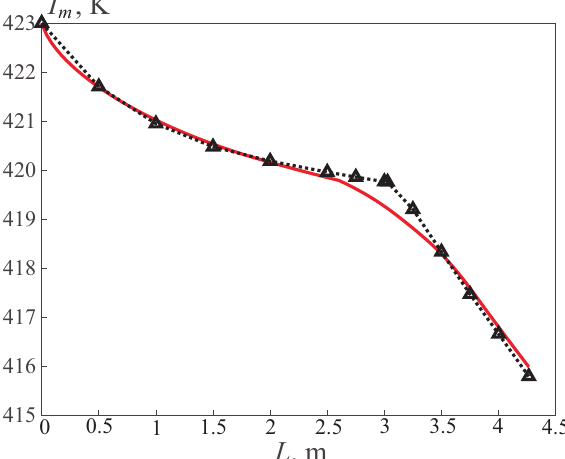
Figure 7. Mass–average water temperature distributions along the length. The solid line corresponds to the results obtained on the basis of the theoretical approach, and the dotted line with triangular marks corresponds to the results of numerical calculations.